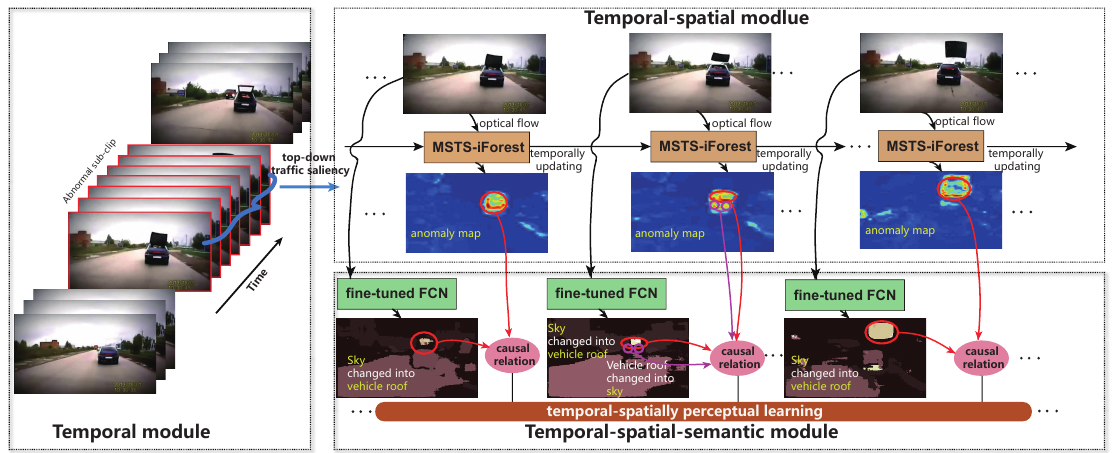
Figure 2. The temporal-spatial-semantic (TSS) model for driving anomaly detection and recounting. Temporal module. In the temporal module, we novelly introduce the top-down traffic saliency to represent the eye fixation variation caused by varying driving scenes. The underlying meaning